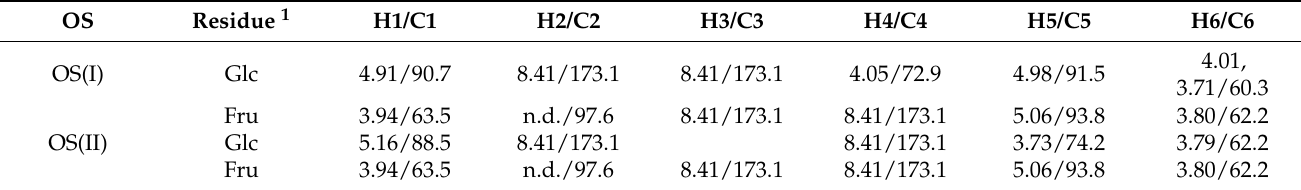
Figure 2. Water-suppressed 1 H (top) and quantitative 13 C (bottom) NMR spectra of the oxidized internal standard. Table 1. 1 H and 13 C chemical shifts of the prepared OS (298 K, D 2